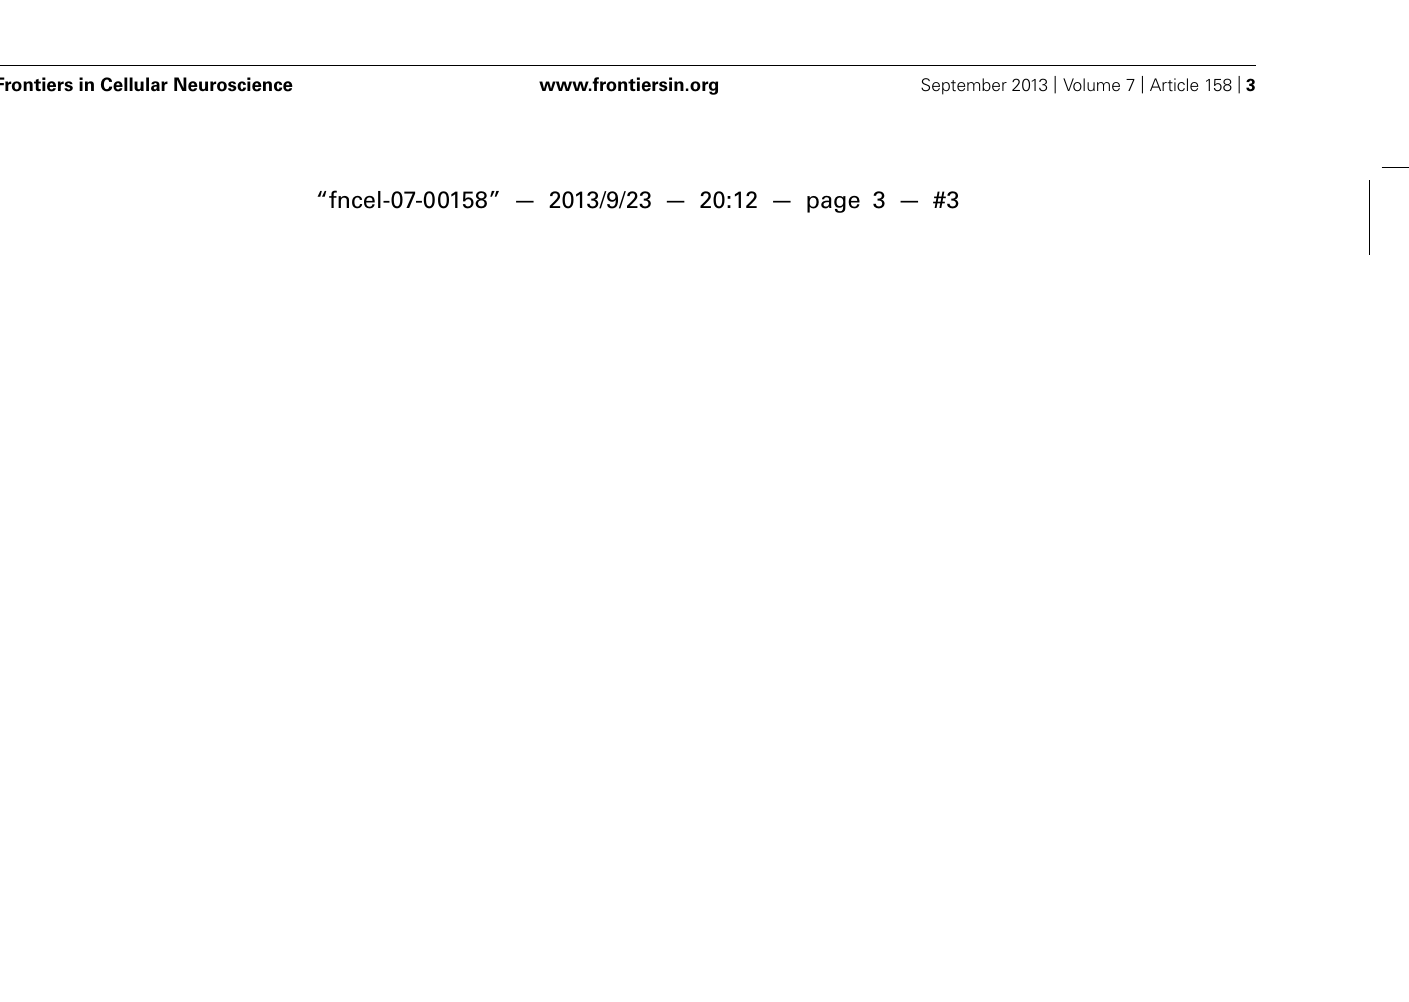
FIGURE 1 | Priming and boosting model ofASE asymmetry. ASEL: (1)The first step of promoting the ASEL cell fate occurs six cell divisions before the postmitotic ASEL is born. A transient pair ofT-box transcription factors TBX-37/38 acts on the downstream primer element of lsy-6 miRNA to open up the chromatin. (2)The priming event allows boosting of lsy-6 miRNA levels by the CHE-1 transcription factor in the ASEL mother cell, leading to high levels of the miRNA in the postmitotic ASEL neuron. (3)The lsy-6 miRNA directly inhibits the ASER promoting transcription factor COG-1, and allows